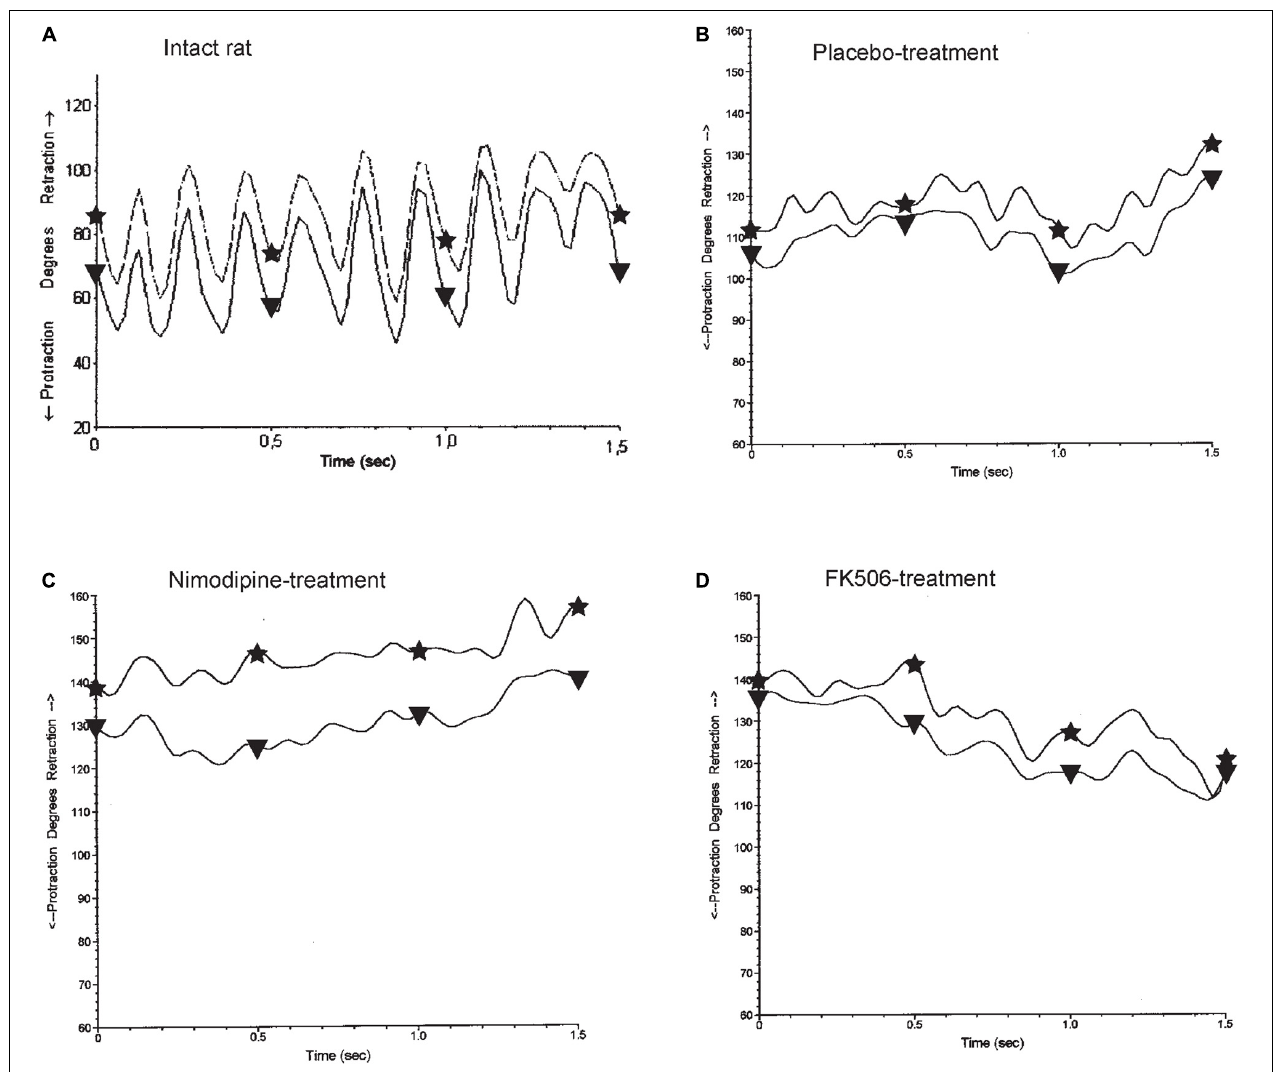
FIGURE 3 | Whisking in normal and experimental rats. (A) In the normal intact rats, both vibrissae of the same side show the synchronous sweeping movement of active protraction ( asterisk ) and passive retraction ( triangle ) anhat is characteristic for explorative behavior adopted with permission from Guntinas-Lichius et al. (2002). The graph shows approximately 6 cycles in 1 s, fitting to the measured mean frequency of 6.0 Hz (cf. Table 3 ), 56 days after implantation of an artificial nerve conduit (B–D) . The amplitude and the speed of whisking are notably reduced and the average position of the vibrissae is at a greater angle toward retraction, as active due to mimic musculature protraction instability, which counterbalances passive retraction by elastic connective tissue. Neither treatment of placebo (B) , nimodipine (C) , nor FK506 (D) improved the functional outcome. (A) normal intact rat, (B–D) operated side 56 days after artificial nerve conduit